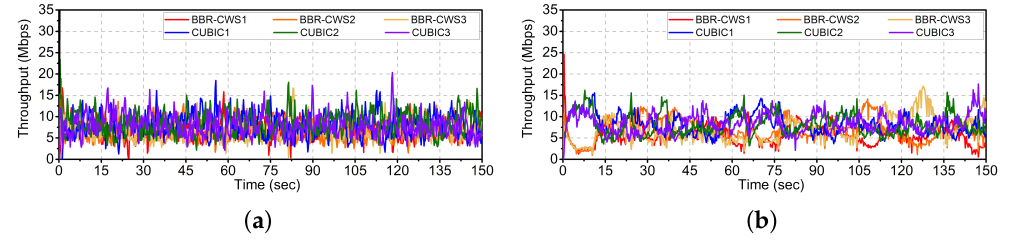
Figure 15. Three BBR-CWS vs. three CUBIC: ( a ) shallow buffer (0.8 BDP); and ( b ) deep buffer (5